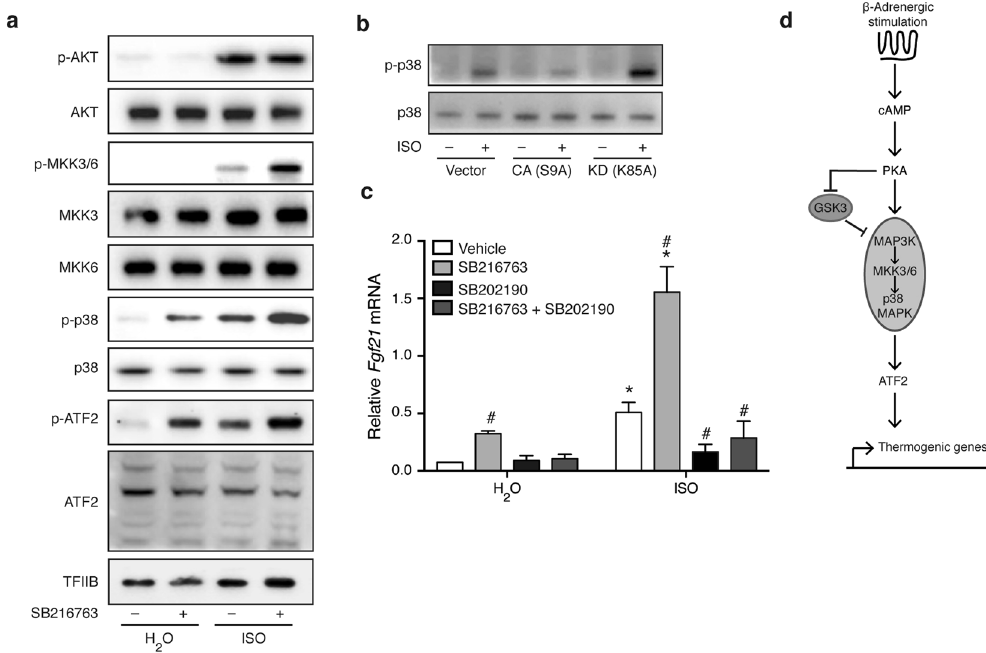
Figure 6. Inhibition of GSK3 promotes activation of the MKK3/6-p38 MAPK-ATF2 signaling module. ( a ) Immunoblot analysis for activating phosphorylations of proteins of the MKK3/6-p38 MAPK-ATF2 signaling module in primary brown adipocytes pre-treated with 10 μ M SB216763 for 1 h before stimulation with 0.1 μ M ISO for 1 h. ( b ) Immunoblot analysis of total and phosphorylated p38 MAPK in immortalized brown adipocytes overexpressing GSK3 β mutants or empty vector. Cells were treated with 0.1 μ M ISO for 1 h. ( c ) Fgf21 expression in primary brown adipocytes pre-treated with 10 μ M SB202190 (p38 MAPK inhibitor) for 1 h before treatment with 10 μ M SB216763 (GSK3 inhibitor) for 1 h, followed by stimulation with 0.1 μ M ISO for additional 6 h. ( d ) Schematic presentation of the proposed mechanism through which GSK3 regulates the thermogenic gene program in brown adipocytes. Data presented as mean of means + SEM (n = 3). Statistical significance was determined by two-way ANOVA with repeated measures and Tukey’s post hoc test for multiple comparisons. * p < 0.05 versus H 2 O. # p < 0.05 versus vehicle. For panels a and b, full-length blots/gels are presented in Supplementary Fig.